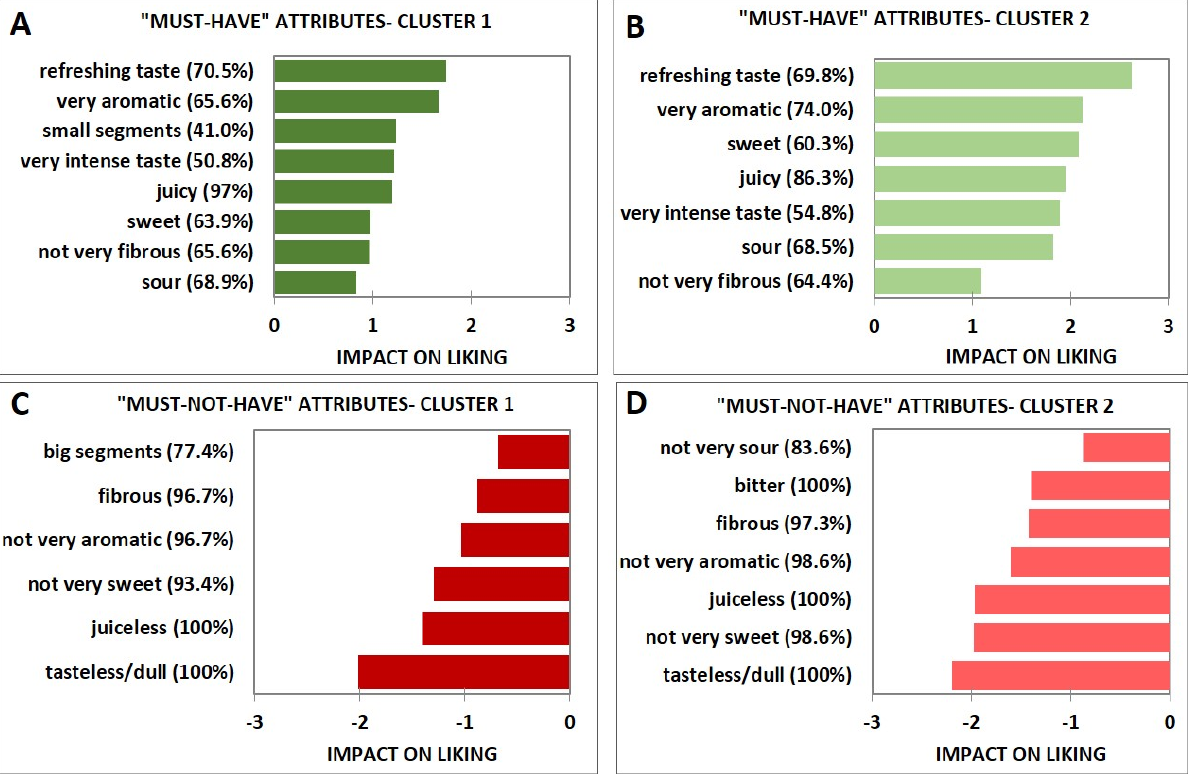
Figure 2. Penalty analysis. Impact on the average liking scores of the “must-have” and “must-NOT-have” attributes for Cluster 1 ( A , C ) and Cluster 2 ( B , D ) consumers. Only the attributes with a significant impact on liking ( p < 0.05) were included. For each attribute, the percentage of consumers who selected it for their ideal mandarin was indicated (see brackets).